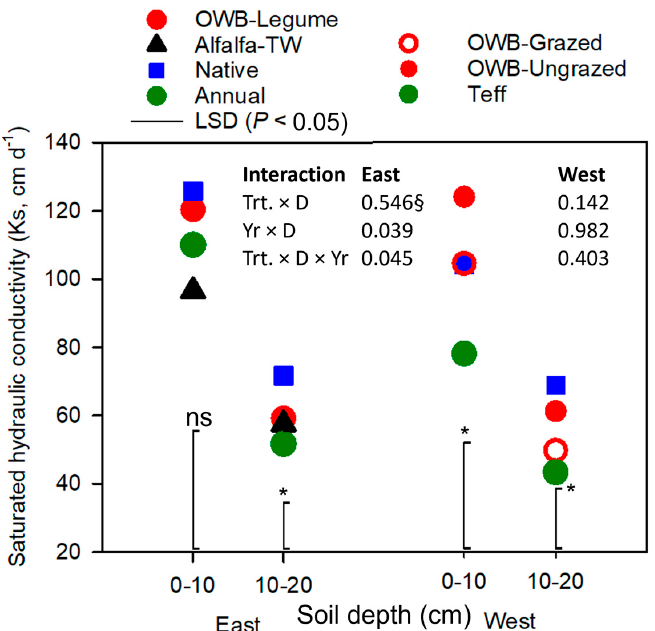
Figure 3. Saturated hydraulic conductivity ( k s ) at soil depths (D) of 0–10 and 10–20 cm for Old-World bluestem (OWB)-legume, alfalfa-tall wheatgrass (TW), native, and annual treatments (Trt.) in the east pasture area; and native, OWB-grazed, OWB-ungrazed, and teff in the west pasture area. Data were averaged across years (Yr 2016 and 2017), sampling locations, and replicates. LSD (least significant difference), represented by vertical line with the asterisk (*), is considered significant at α = 0.05; ns, LSD (vertical line without the asterisk) is nonsignificant at α = 0.05; §, P value of the interaction.